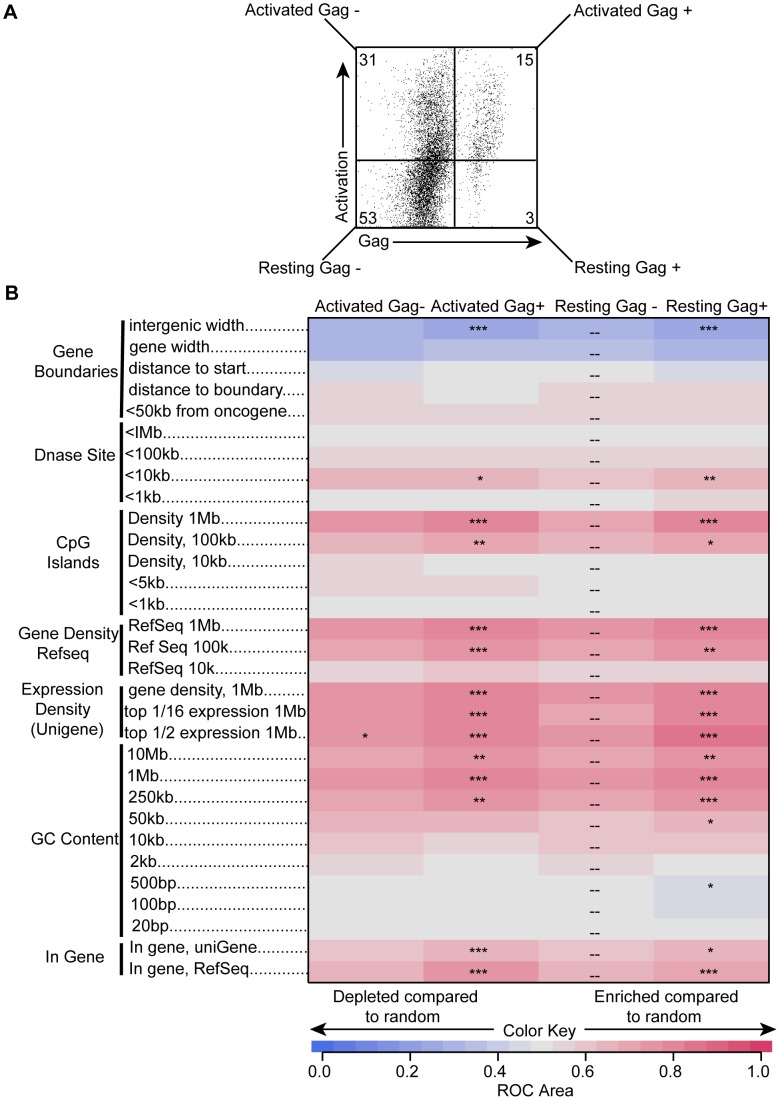
Differences in HIV integration site selection between Gag positive and negative cells.Unstimulated cells were spinoculated with NL4-3. At 96 hours post infection, cells were stained with antibodies for the activation markers HLA-DR, CD25, and CD69 as well as for intracellular Gag. Cells were sorted into 4 populations: activated Gag−, activated Gag+, resting Gag−, and resting Gag+. Numbers reflect the percentage of each population in the total infected unstimulated cells (A). A heatmap showing relationships of integration site distributions to various genomic features is shown in (B). Each column represents a different population and each row a genomic feature. Darker shades of red indicate associations observed more than random and darker shades of blue indicate less than random. *p<0.05, **p<0.01, ***p<0.001.